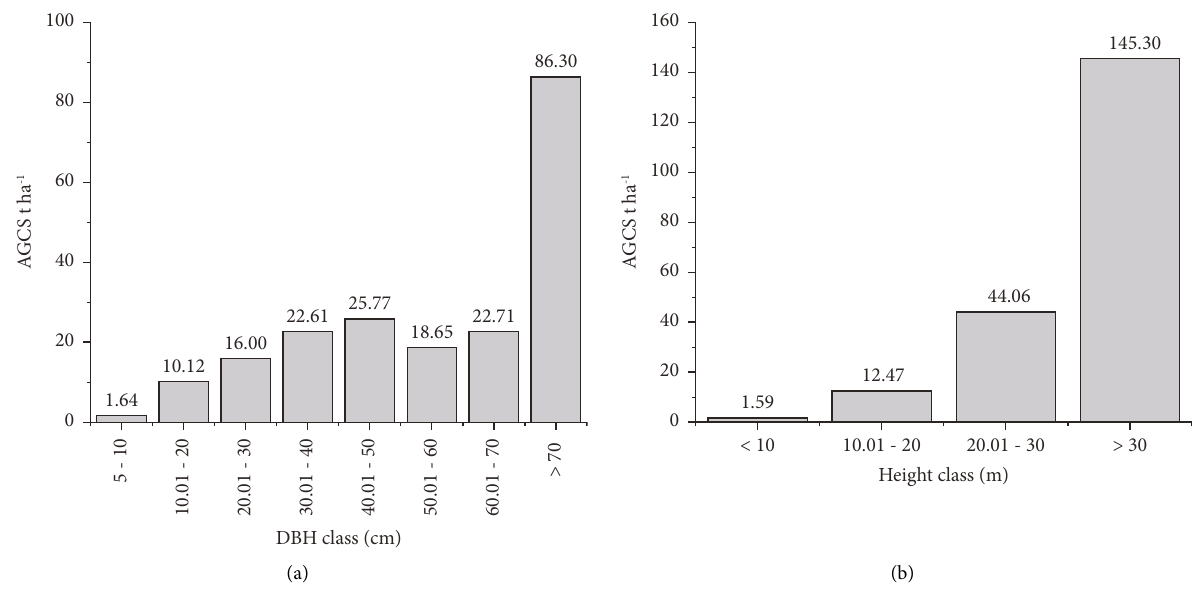
Figure 2: Variation of AGCS across DBH class (a) and height classes (b). Table 2: Comparative analysis of mean carbon stock between elevation, slope, and aspect